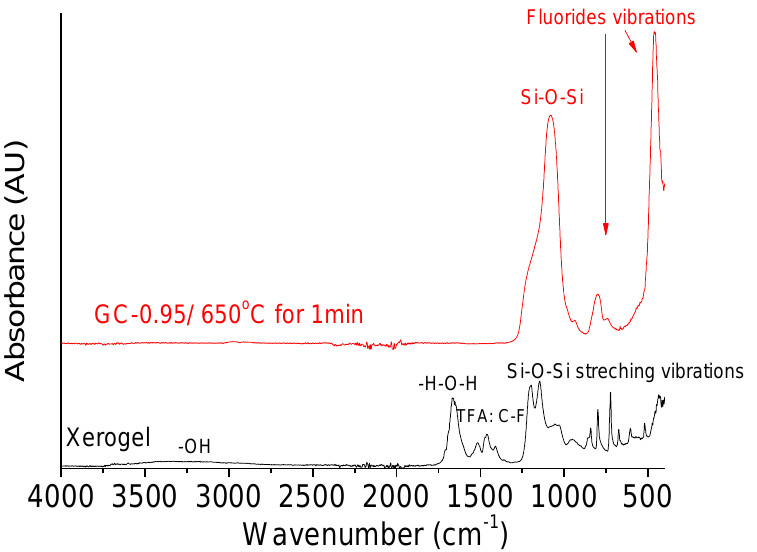
Figure 3. FTIR analysis of Sol-0.95 xerogel and GC-0.95 glass-ceramic thermally treated at 650 °C for 1 min with a rate of 10 °C/min.